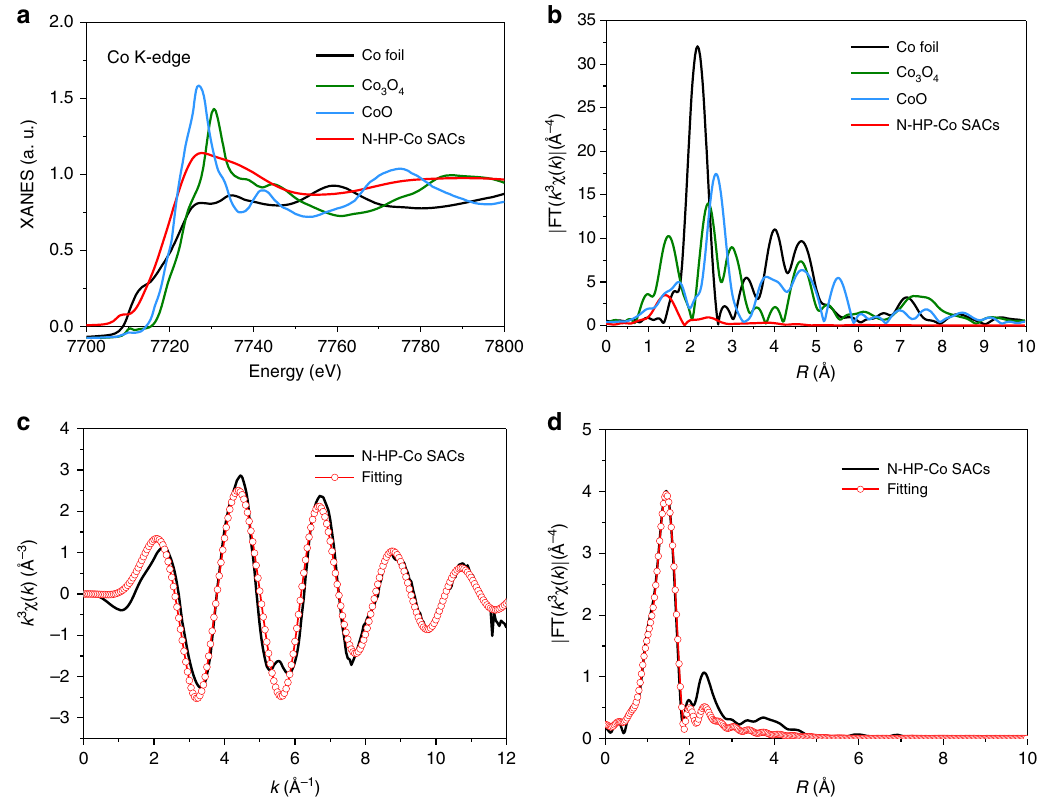
Fig. 3 Atomic structural analysis. a XANES spectra and b Fourier transform of the Co K-edge of N-HP-Co SACs Co 3 O 4 , CoO, and Co foil. c , d The corresponding EXAFS fi tting curves of N-HP-Co SACs at the k space and R space,